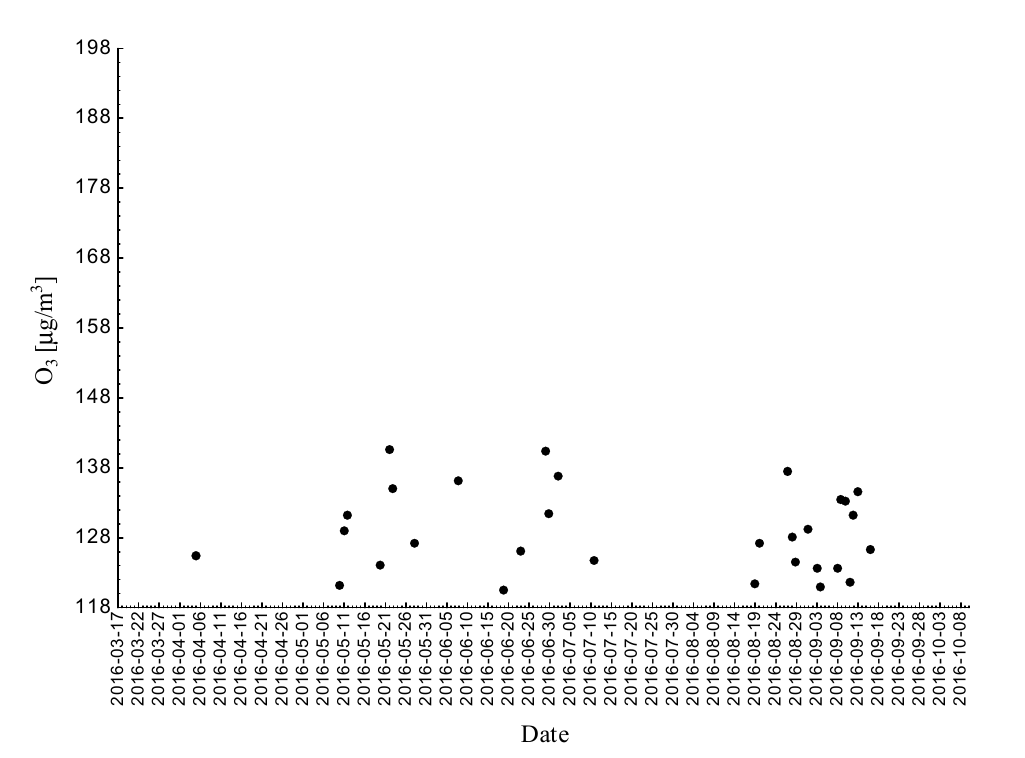
Figure 8. Maximum daily 8-h mean ozone concentration not less (equal to or more than) than 120.4 µg/m 3 registered at the measurement station in Zloty Potok (SL03ZP) in 2015.